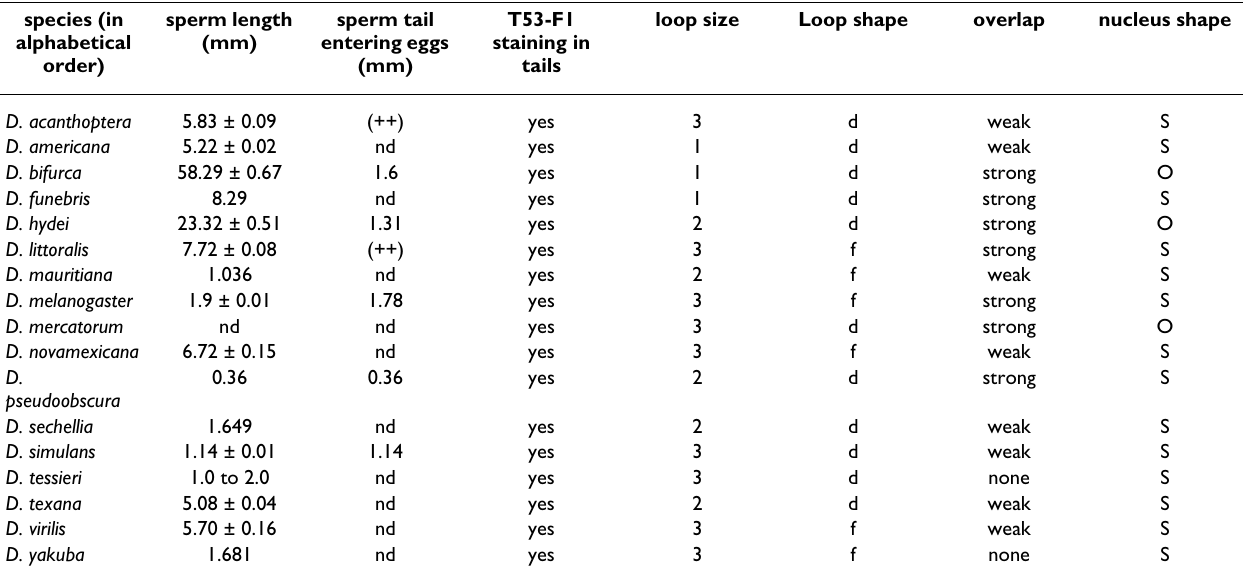
Table 1: Analysis of various aspects of male spermatogenesis in different drosophilids species (in alphabetical